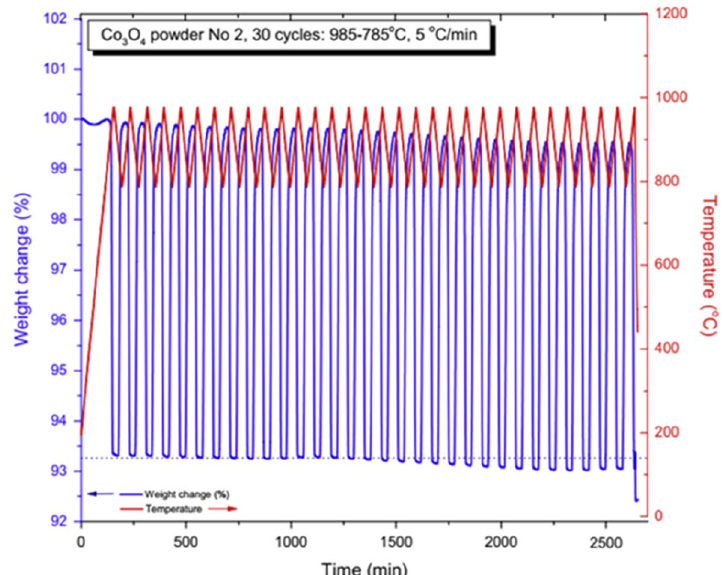
Fig. 14 30 cycles experiment of Co 3 O 4 powder in the TGA between 985 and 785 °C with a heat/cooling rate of 5 ℃ /min. (Weight loss: 6.75% for the 1st cycle vs. 6.50% for the 30th cycle)